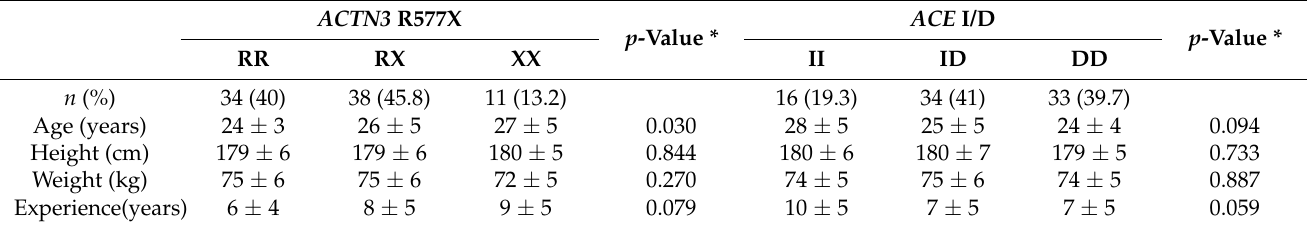
Table 1. Subjects characteristics according to the ACTN3 R577X and ACE I/D genotypes. ACTN3 R577X